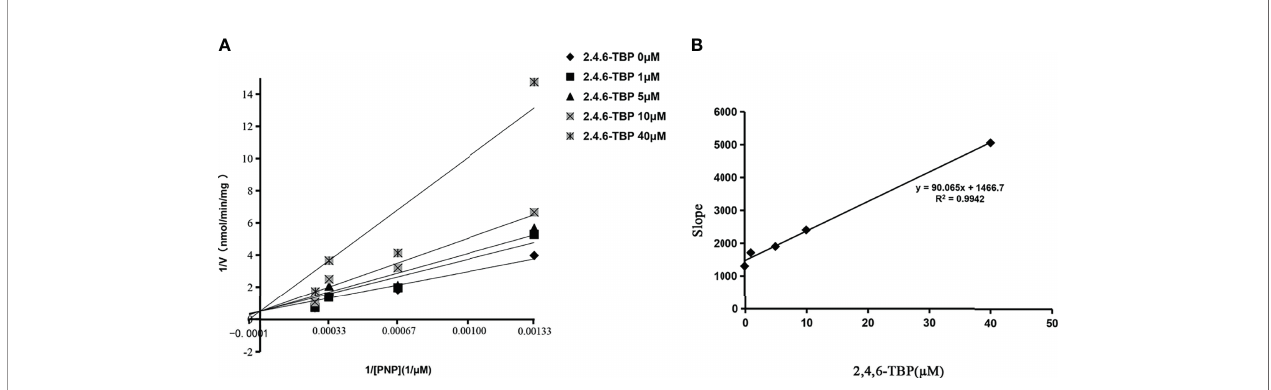
FIGURE 3 | The Lineweaver-Burk plot of 2,4,6-TBP to SULT1A3. In (A) , the horizontal axis represents the value of 1/[PNP]. The vertical axis represents 1/V. V is the velocity of the reaction. K i values were calculated using the slopes of (B) .